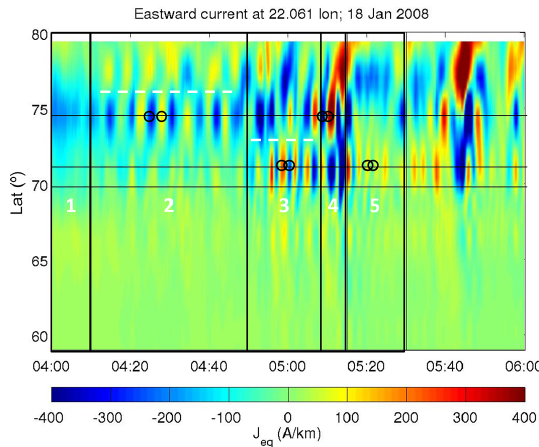
Figure 4. Eastward equivalent currents along the geographic merid- ian 22.1 ◦ E during 04:00–06:00UT on 18 January 2008. (The verti- cal axis is in geographical latitudes.) The five periods with different characteristics in 2-D equivalent current patterns are marked with black boundaries and white numbering. The geographic latitudes of stations BJN, NOR, and KEV are marked with the black horizon- tal lines from top to bottom, respectively. The auroral breakup at midnight sector took place at the beginning of Period 4. The white dashed lines show the maximum FLR latitude based on Fourier analysis of 3.1 and 5.2mHz magnetic variations. The time instants of the 2-D equivalent current maps of Fig. 6 are shown with the black